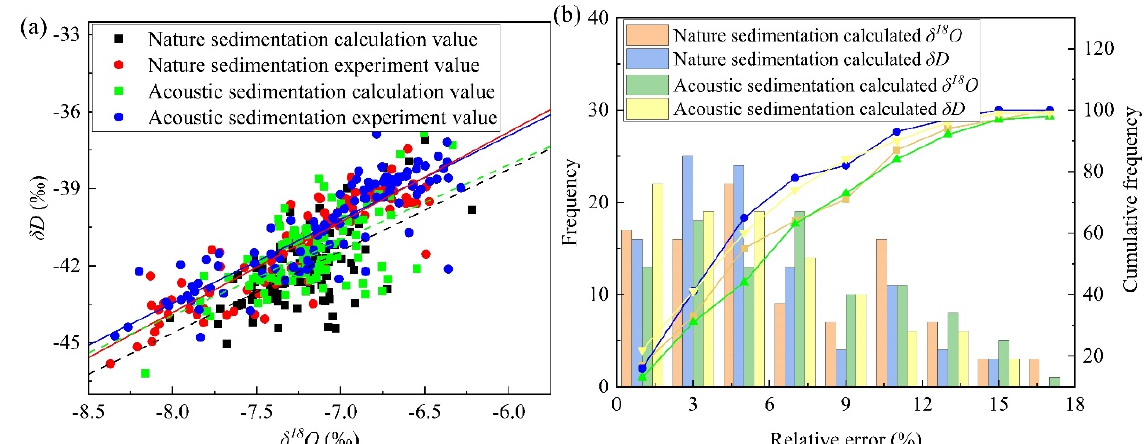
Figure 9. ( a ) Comparison of theoretical and experimental values of the micro-droplet isotopes inside the air chamber and ( b ) their relative error distribution.